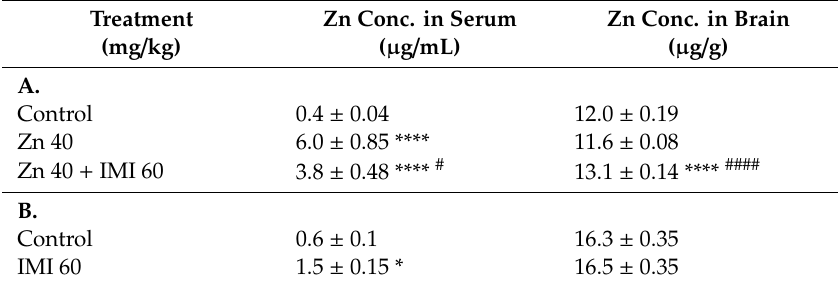
Table 2. E ff ect of IMI on the concentrations of Zn in mouse serum and brain.